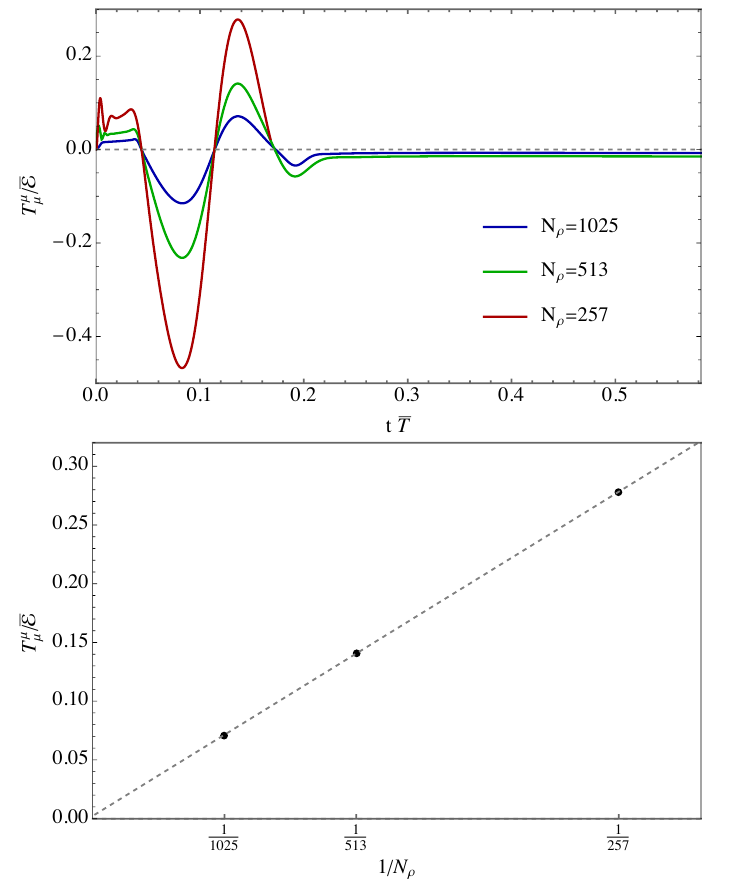
Figure 5 . Convergence test for the trace. (Top) Trace at the center of the domain { x, y } T ’ { 0 , 0 } as a function of time, for three different resolutions along the holographic direction N ρ = 257 , 513 , 1025 . The data for the N ρ = 257 case is only available up to tT ’ 0 . 17 . (Bottom) Trace as a function of 1 /N ρ at a fixed time tT ’ 0 . 14 , at the center of the domain. The dashed line is a straight line fit that shows first order